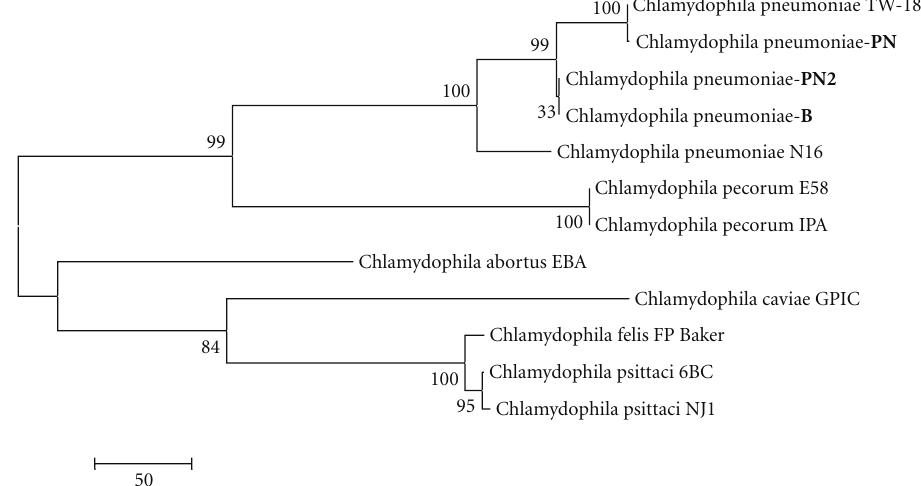
Figure 2: Dendrogram resulted from phylogenetic analysis of middle fragment of 16S–23S rRNA genes and 23S rRNA area of Chlamydophila Chlamydia strains I segment by means of Maximum Parsimony method with execution of Bootstrap Test of Phylogeny (1000 repetitions), p -distance model reflecting position of Chlamydophila pneumoniae strains being under investigation (PN: monkey strain, PN2: human strain, and B: reference